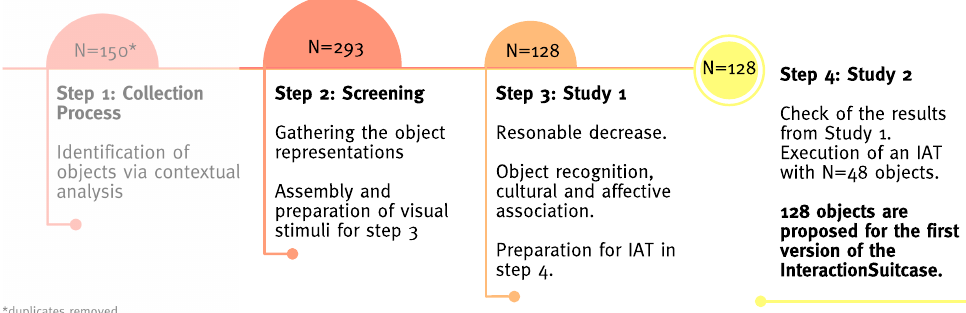
Figure 1. Step 1 describes the collection process. Step 2 screens the objects according to predefined criteria. Step 3 describes a study with a homogeneous sample. The objects were examined for recognition and cultural association i. a. in preparation for IAT in step 4. In step 4, a second study was conducted where the results from Study 1 were verified, and an implicit association test (IAT) was performed. Hereby, a heterogeneous sample was